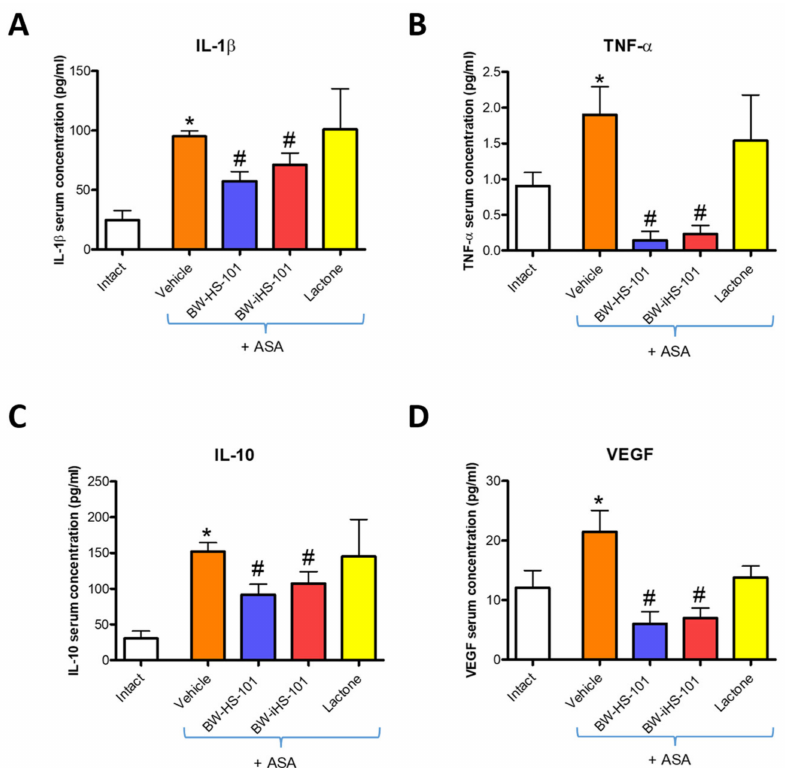
Figure 3. Concentration of interleukin (IL)-1 β ( A ), tumor necrosis factor (TNF)- α ( B ), IL-10 ( C ), or vascular endothelial growth factor A (VEGF) ( D ) in serum of rats administered i.g. with acetylsalicylic acid (ASA, 125 mg/kg) and pretreated 30 min earlier with vehicle, BW-HS-101 (50 µ mol/kg), BW- iHS-101 (50 µ mol/kg), or lactone (50 µ mol/kg). Results are mean ± SEM of five rats per each experimental group. Significant changes as compared with the respective values in intact rats are indicated by asterisk (*) ( p < 0.05). Hash (#) indicates significant changes as compared with vehicle ( p <